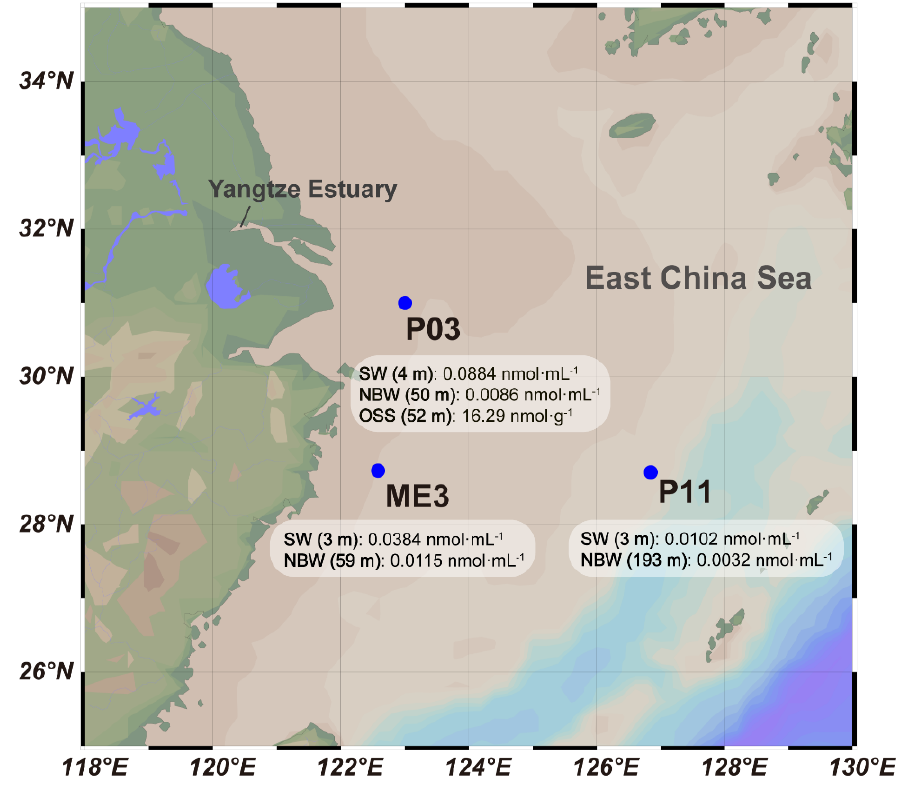
Figure 1. East China Sea sampling site locations and total DMSP concentrations. SW: surface water, NBW: near bottom water, OSS: oxic surface sediment. NBW samples were taken at depths of 59, 52 and 193 m at sites ME3, P03 and P11, respectively.